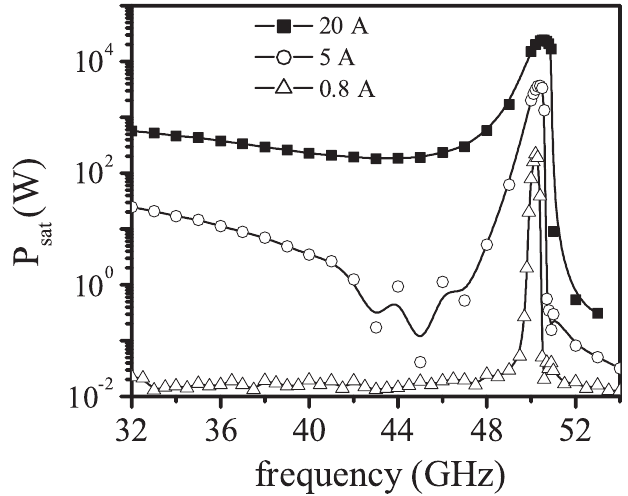
FIG. 1. Saturated power versus the frequency of the seed field for the electron-beam currents of 0.8, 5, and 20 A and no fluctuations in the liner radius. Lines are for guidance.